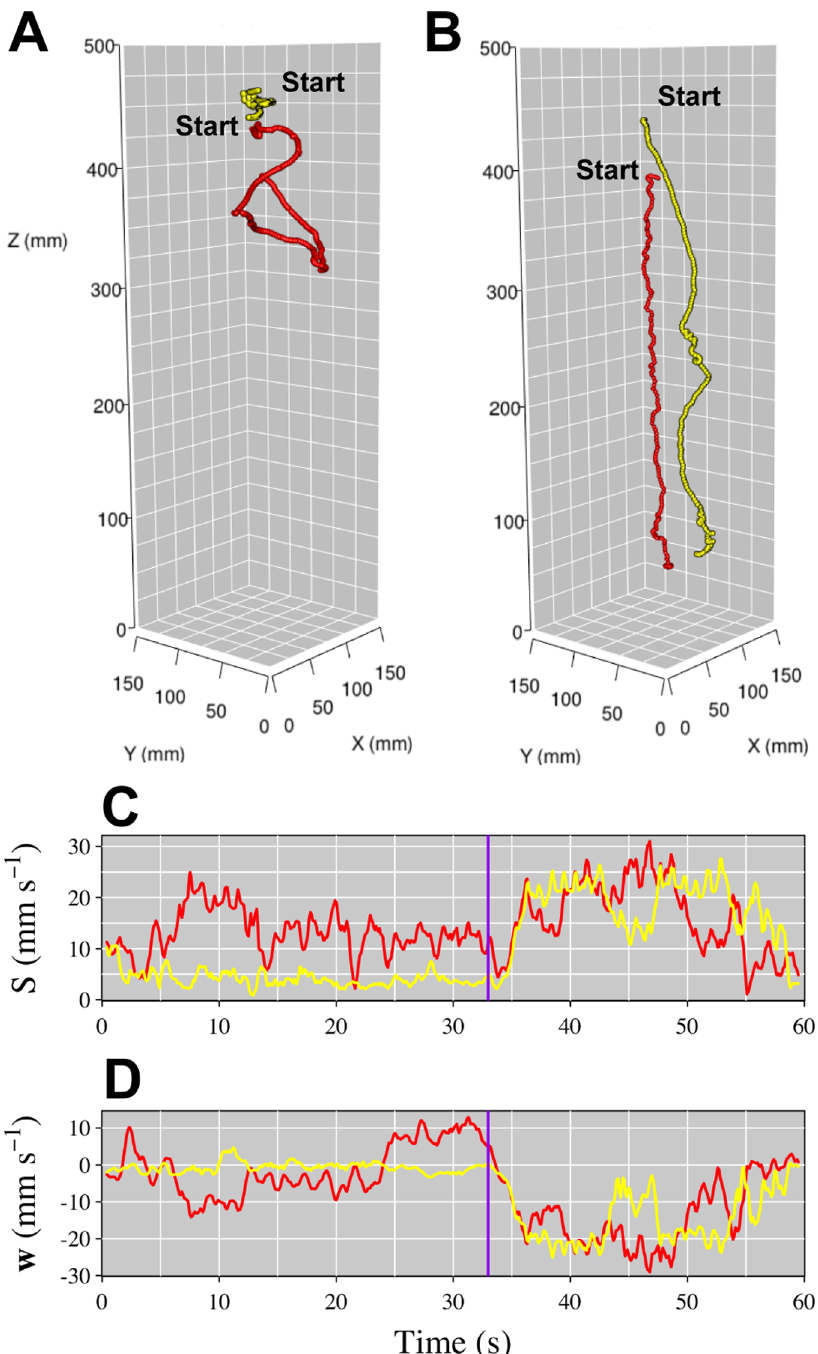
Figure 4. Tracking of the position, speed and vertical displacement of two D.magna in the absence and presence of UV radiation. Two individuals were labelled with red and yellow quantum dots, respectively, and monitored simultaneously to obtain 3D trajectories of the two organisms in the absence (a) and presence (b) of UV radiation. From the data we also extracted the 3D swimming speed S (c), and vertical velocity w (d). Negative values of w indicate a downward displacement, the purple line marks the time at which the UV light was turned on. See also Video S2 for an animation of the UV response (NOTE: The animation is 40 s, i.e. 20 s UV off + 20 s UV on).